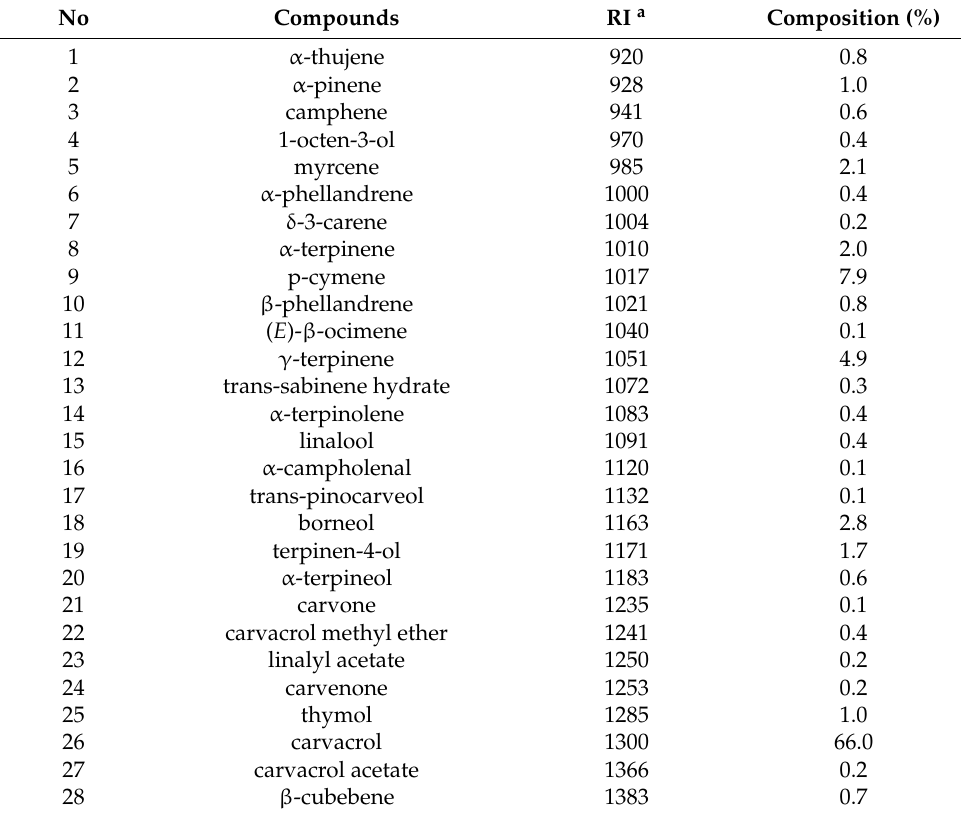
Table 1. Chemical composition (% v / v ) of O. onites essential